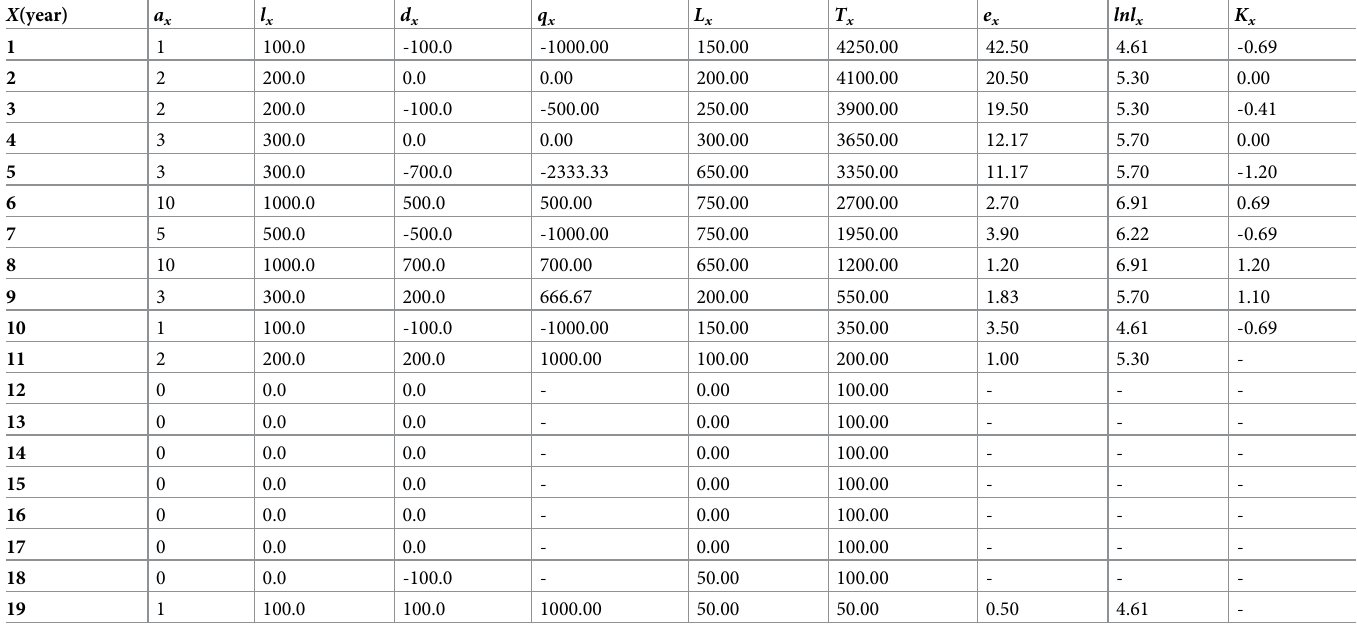
Table 3. Time-specific life table of P . flavus LM